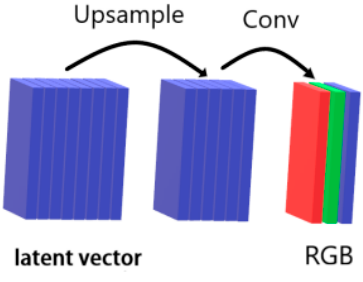
Figure 5. Image generation process.